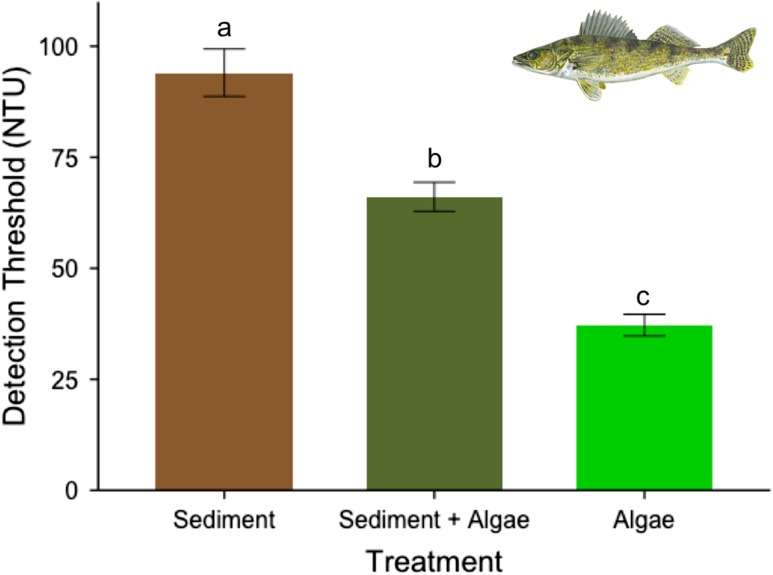
Mean (± standard error) visual detection thresholds for walleye (n = 6). Each individual was tested twice under each of three treatments and the values for an individual within a treatment averaged: sediment (brown bar), combination (dark green bar) and algal (light green bar) turbidity (P < 0.001). Post hoc pairwise comparisons revealed the relationships between each treatment, as indicated by letters above each bar.